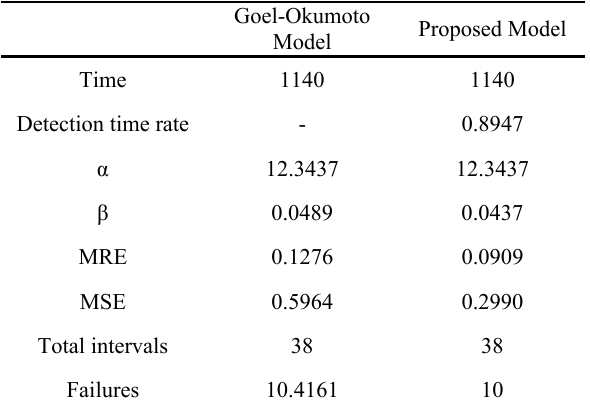
Table 2. Description of Measurement of the Goel-Okumoto